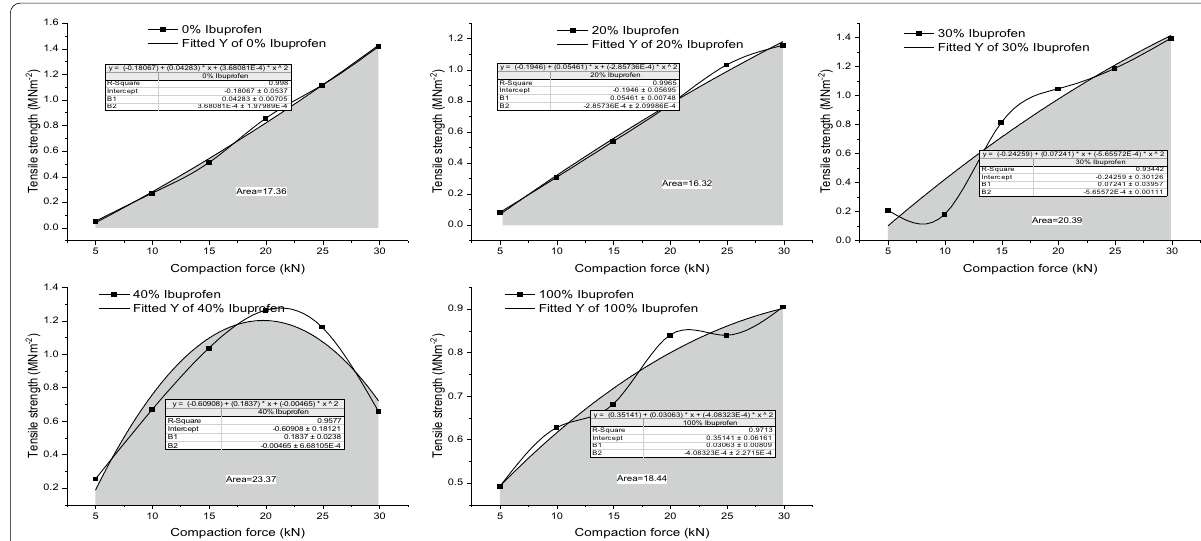
Fig. 2 Area under the tensile strength–compaction force curve for α-lactose-starch orodispersible diluent. Tensile strength computed by Podczeck et al. (2013) model